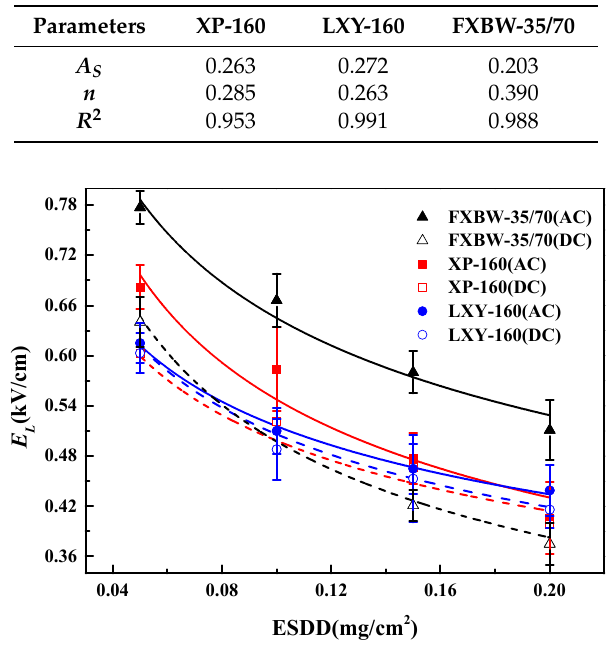
Table 5. Fitting values of A s , n and R 2 according to the test results in Table 4 with Equation (4).